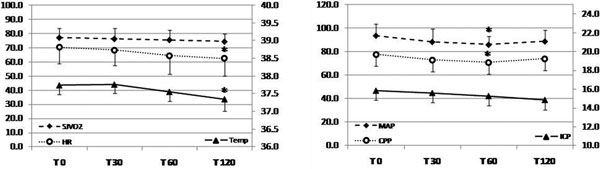
*P <0.05 versus T0.